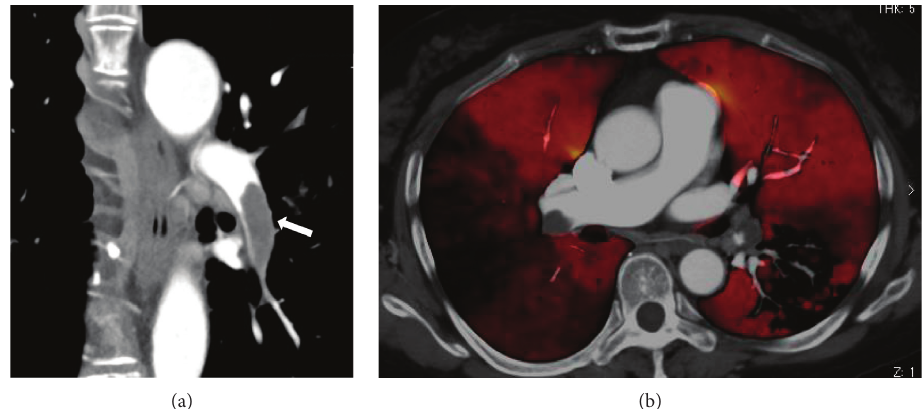
Figure 2: (a) Contrast-enhanced computed tomography (CT) reveals a large lesion filling the left pulmonary artery (white arrow). (b) Dual- energy CT shows areas of severe hypoperfusion in segment S4 of the right lung and segment S6 of the left